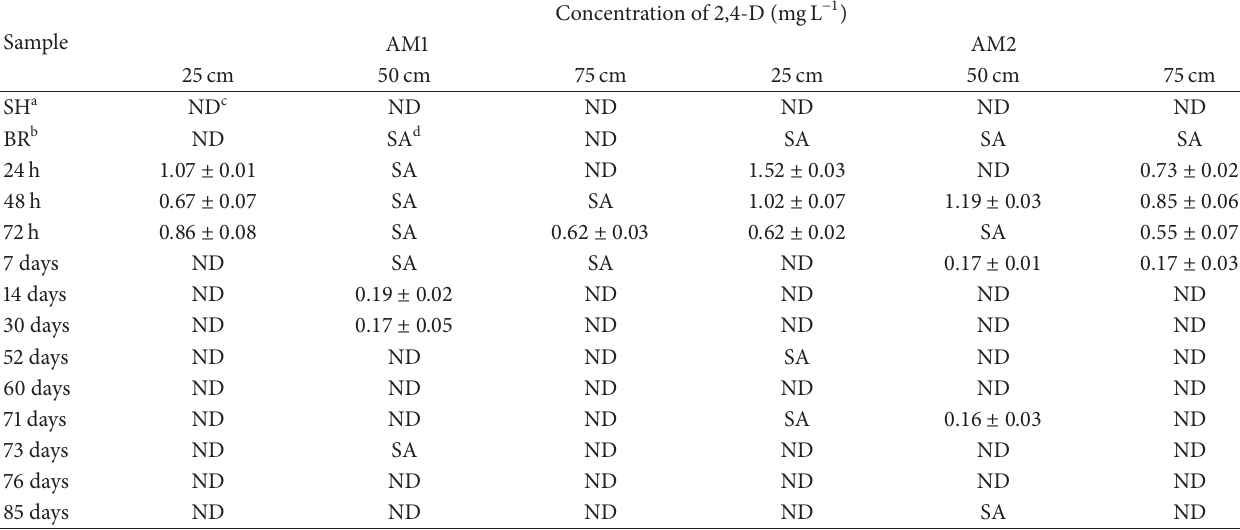
Concentration of 2,4-D (mgL −1